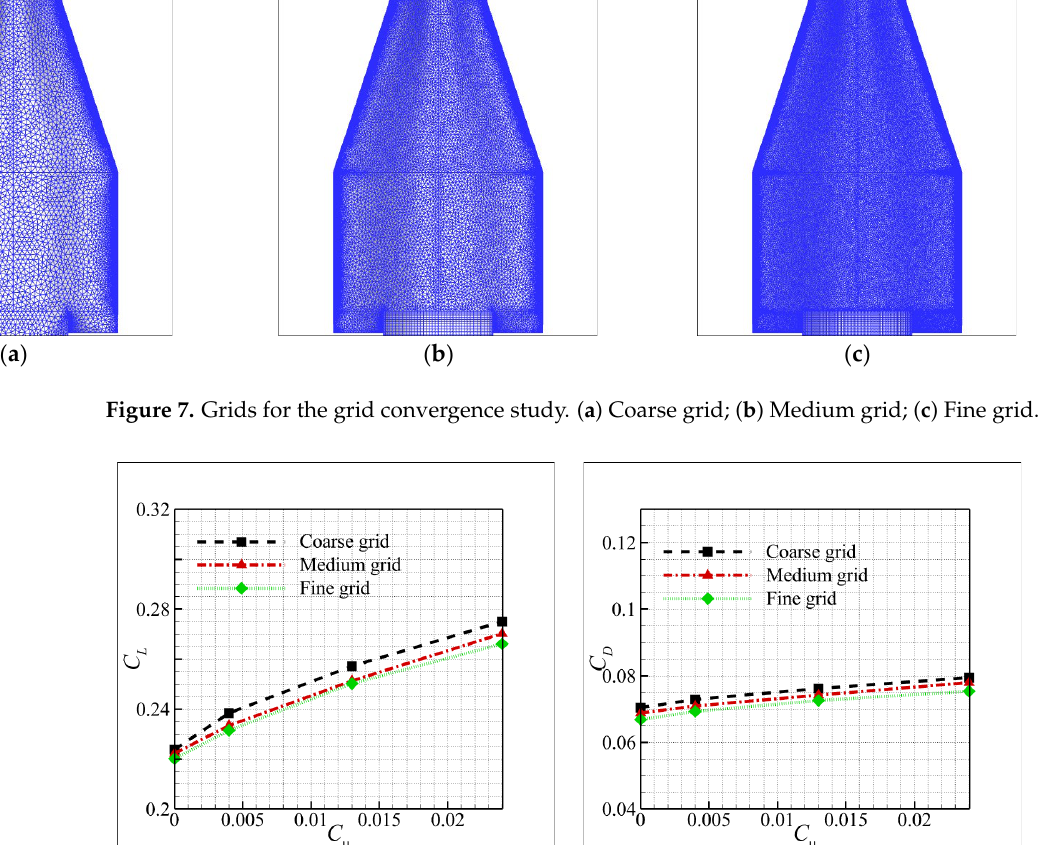
Figure 8. The results of the grid convergence study at